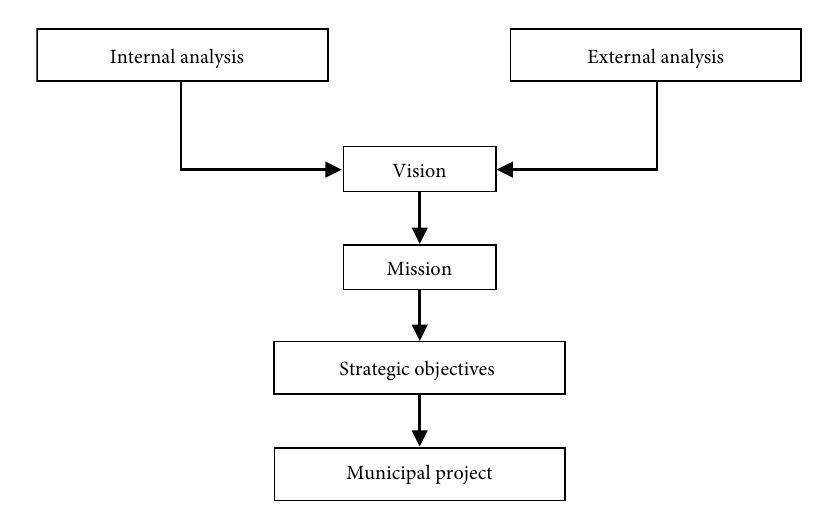
Fig. 1. Municipal project